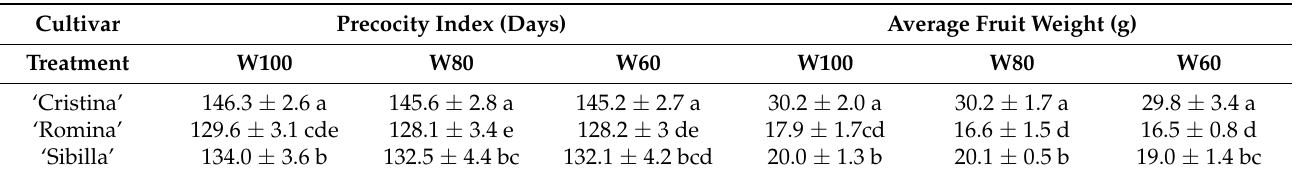
Table 10. Effects of water availability on precocity index and average fruit weight in different strawberry cultivars. Values with the same lowercase letter for the same parameter were not sta- tistically different for Fisher’s LSD test ( p < 0.05). Values are expressed as means of two years (2017–2018) ± standard deviation (SD).